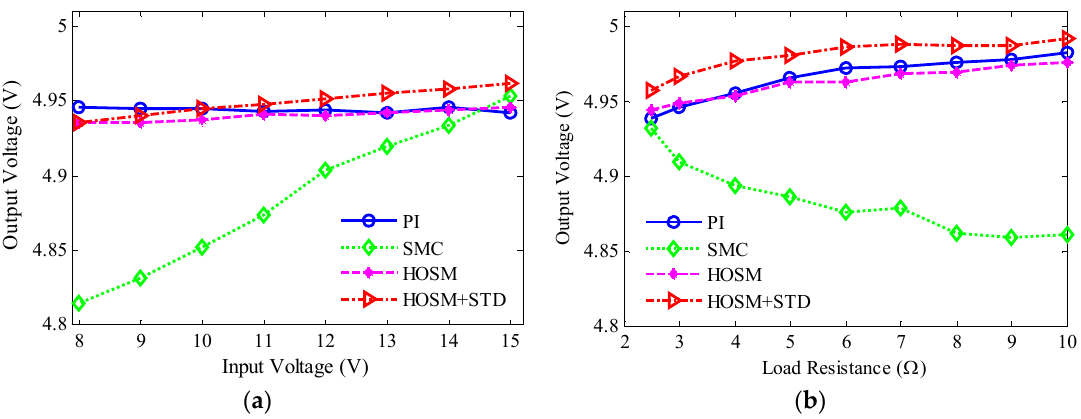
Figure 6. Experimental results of average output voltage ( a ) for different input voltage ( R = 2.5 Ω ); ( b ) for different load resistance ( V in = 15 V).